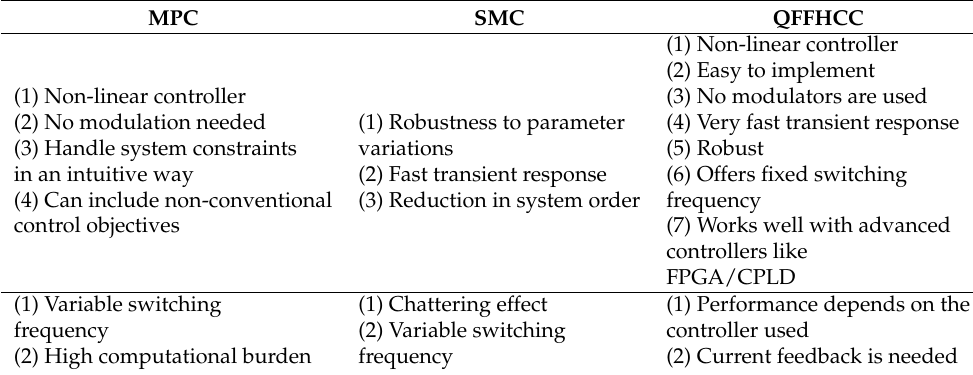
Table 1. Comparison of advanced control strategies with the proposed method. MPC